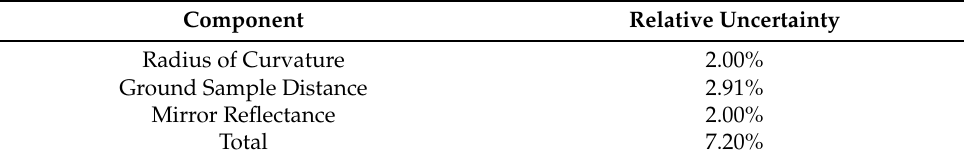
Figure 8. For the UAV single (blue box) and double (orange box) mirror targets ( A ), the predicted Lambertian Equivalent Reflectance (LER), for the mirror targets (solid lines) is compared to spectra extracted (Ext) from the VNIR UAV surface reflectance imagery ( B ). The extracted values agree to the predicted spectra within the k = 1 uncertainty (shaded regions) of the derived LER (7.2%). The paper labels visible next to the mirrors ( A ) were not present during data collection. Validation spectra have been smoothed with a 4th order, 51 channel Savitzky-Golay filter. Table 2. UAV Uncertainty